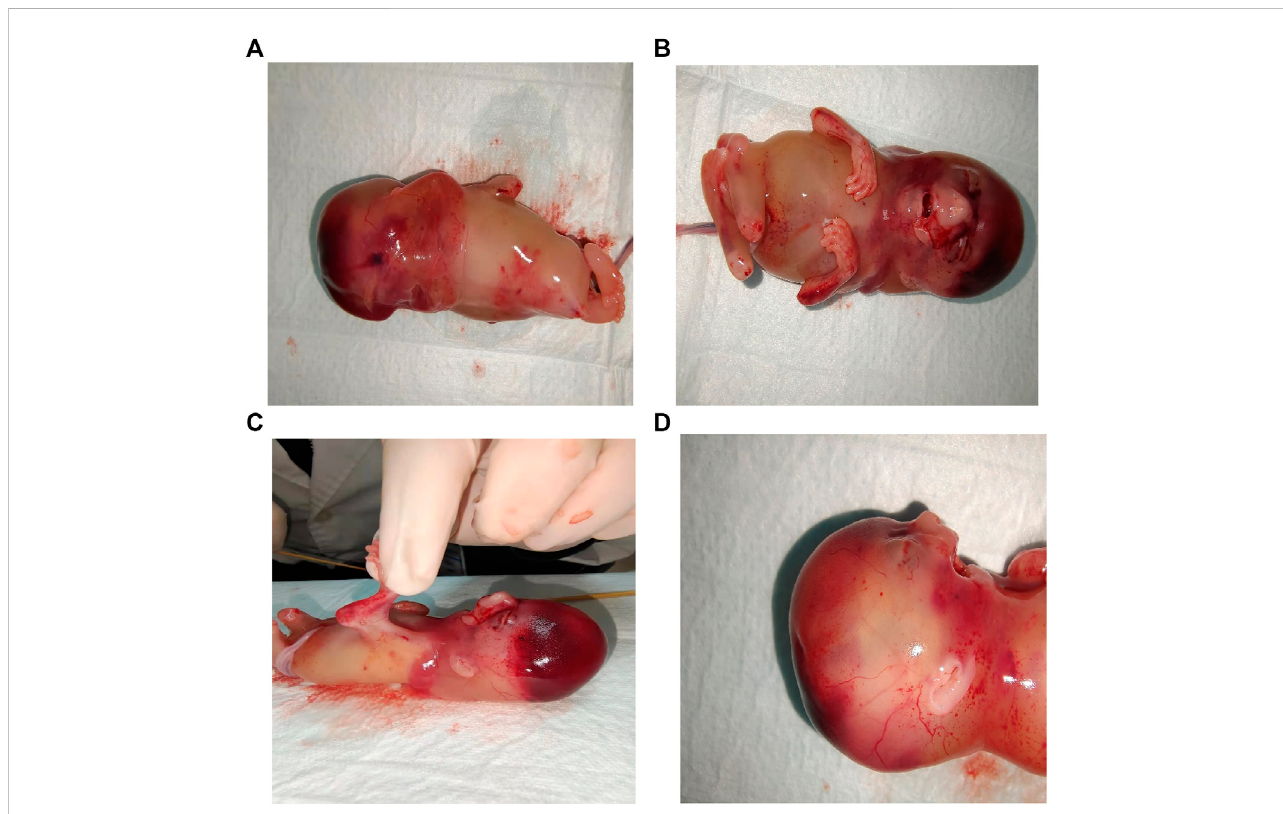
FIGURE 3 Stillbirthphenotypes: (A) Nuchalcystichygroma. (B) Contracturesoftheextremitiesandverticalwrist. (C) Pterygiumofantecubitalandpoplitealregions. (D) Side view: Pterygia of neck, low-set ears, micrognathia and gaping